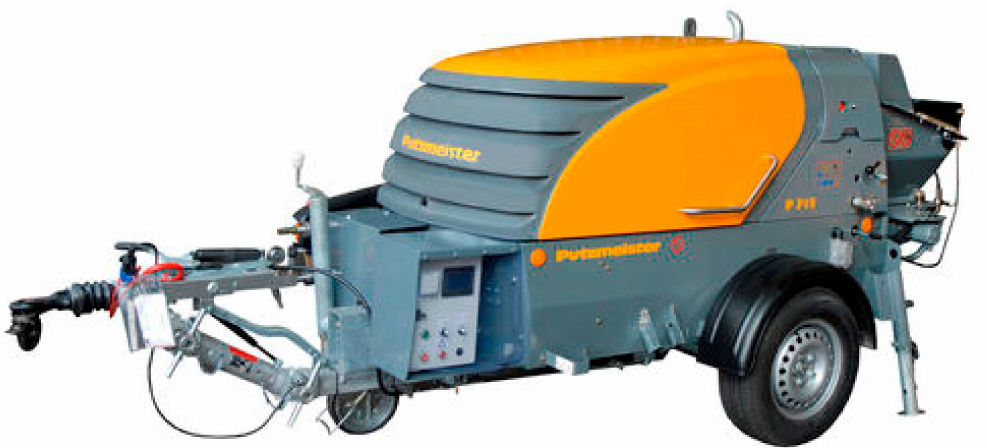
Figure 4. (Sourced from www.putzmeister.com access on 12 November 2021). Small drag pump used for mine